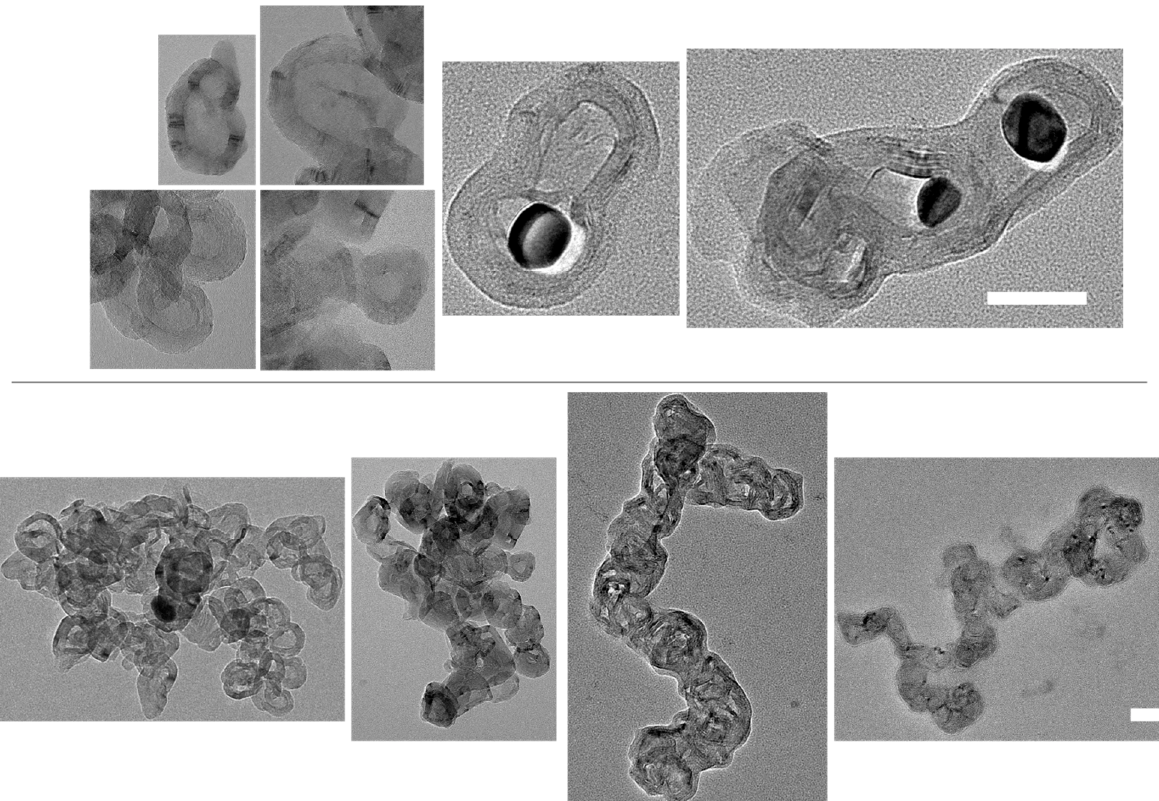
Figure 6. TEM images of individual MGNS particles ( top ) and larger MGNS agglomerate structures ( bottom ). Both scale bars indicate 50